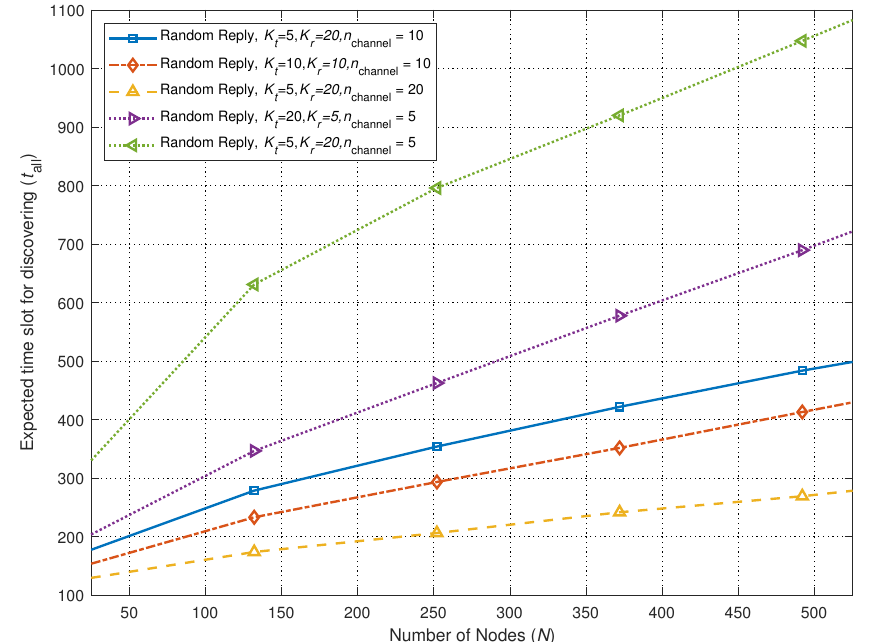
Figure 13. Symmetric K r and K t with different numbers of